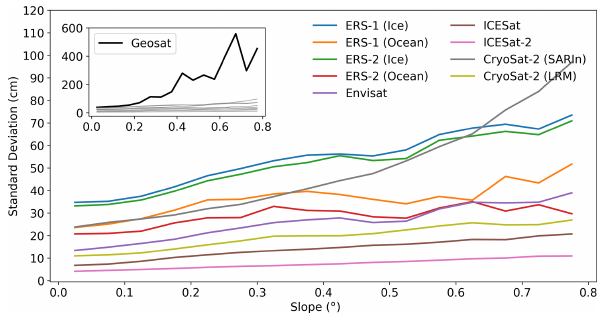
Figure 6. Standard deviation (cm) of intra-mission and intra-mode crossovers for the Antarctic Ice Sheet as a function of surface slope (degrees). Precision decreases quasi-linearly as surface slope in- creases. Table 1. Sensor and mode errors ( σ mission ) as a function of the random ( σ noise ) and slope-dependent ( σ slope ) errors. Slope ( α ) is in degrees. Modeled error ( σ mission ) is based on fitting the following function to the intra-sensor, intra-mode crossover data: σ mission = σ noise + σ slope α 2